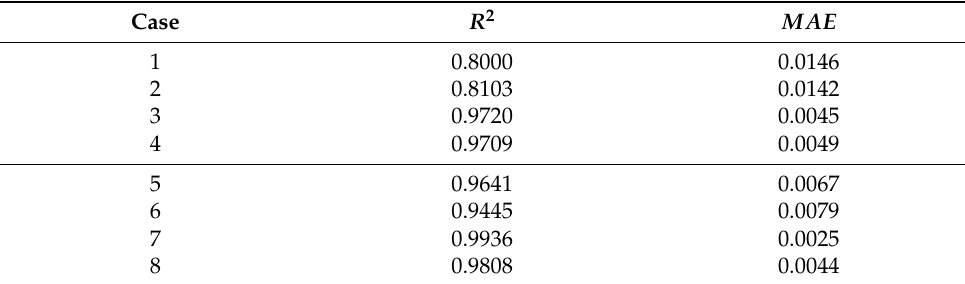
Table 8. Comparison of the prediction performance of model cases using test data set.